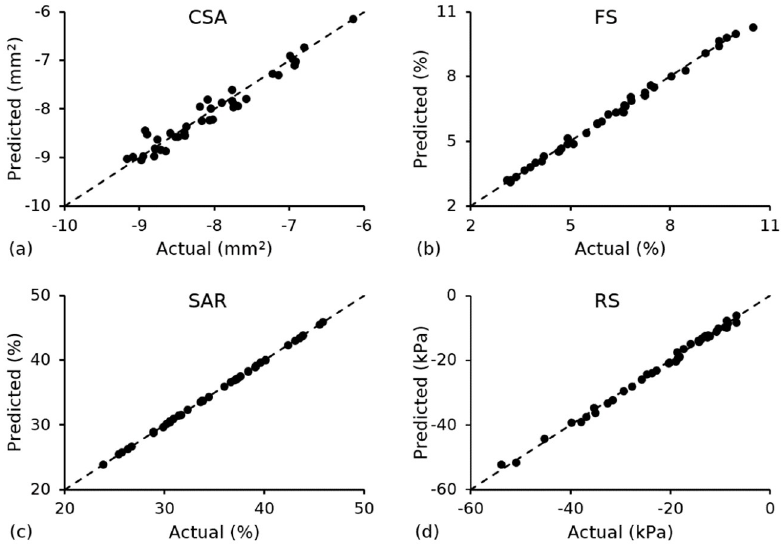
Fig 7. Predicted response using the statistical model in Eq 16 vs. actual (measured) response from finite element simulations for (a) CSA ; (b) FS ; (c) SAR and (d) RCP .